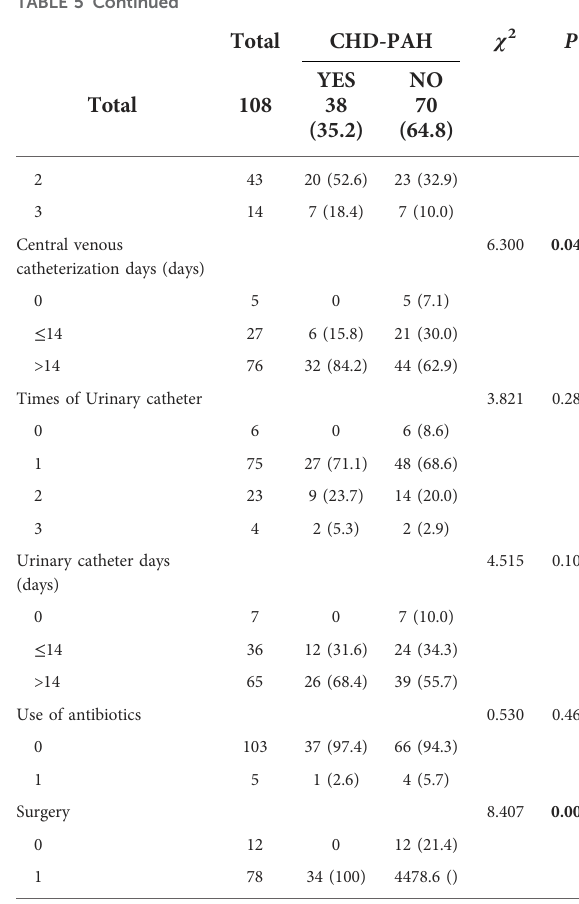
Bold value indicates the difference was signi fi